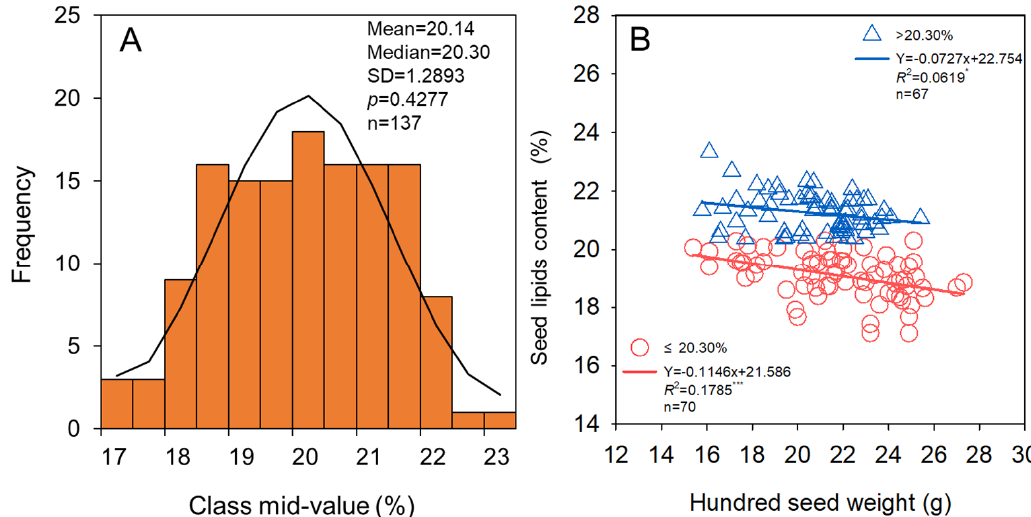
Figure 8. Relationship of seed lipids content ( A ) and hundred seed weight ( B ) for soybean. * and *** indicate significance different at the 0.05 and 0.001 probability levels, respectively.